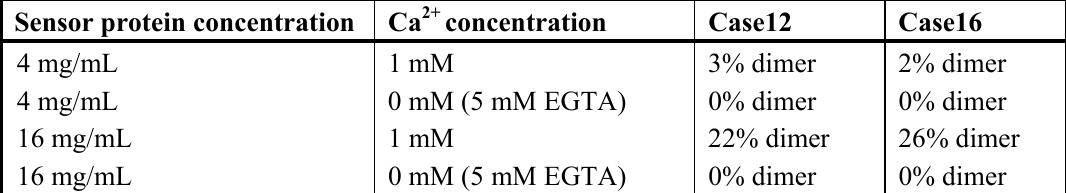
Table 2. Dimerization rate of Case12 and Case16 in the presence/absence of Ca 2+